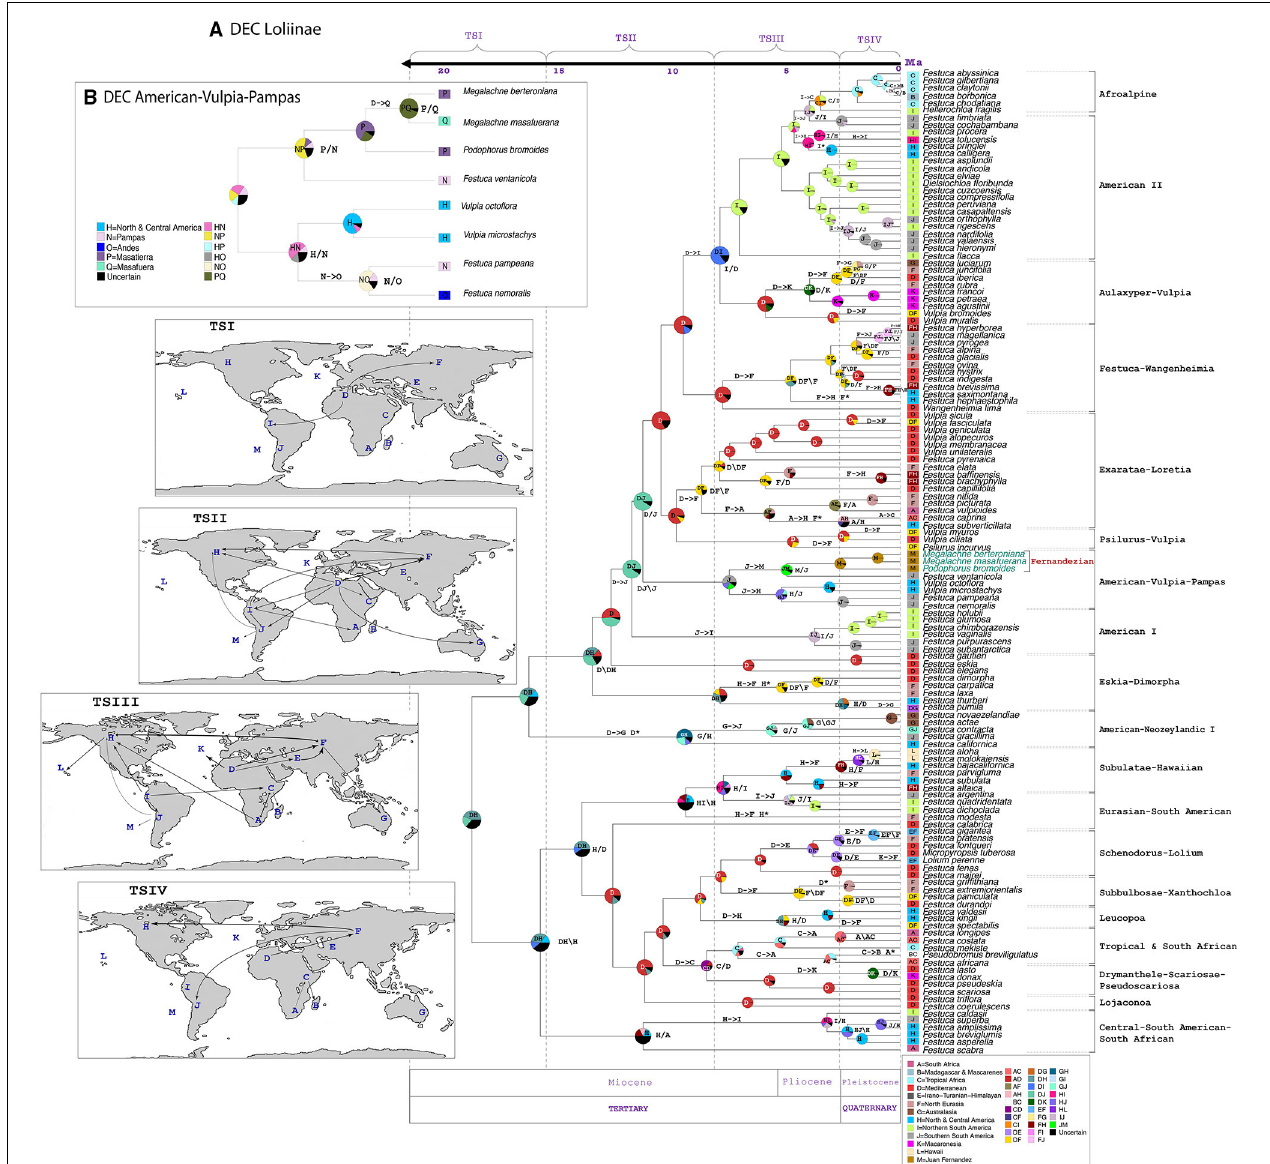
FIGURE 5 | Estimated ancestral ranges and biogeographical events of the Fernandezian and other Loliinae grasses inferred from LAGRANGE under the stratified DEC models mapped on the BEAST2 maximum clade credibility tree with outgroups pruned from it. (A) Loliinae DEC model; (B) American-Vulpia-Pampas DEC model. The vertical dashed lines separate the four time slices (TSI-TSIV) used in the Lagrange analyses. The maps on the left represent the palaeogeographical configuration of the world in these four time periods and the arrows represent the dispersals between areas that reflect change in continental connectivity over time. The pie charts at the nodes indicate the relative probabilities for alternative ancestral ranges (with their color legends indicated at the respective inset charts). The inferred biogeographic events are indicated at the nodes (X/Y vicariance; X\Y peripheral isolation) and branches (X- > Y dispersal; X* extinction) of the tree. The Operational Areas assigned to the species are indicated to the right of the